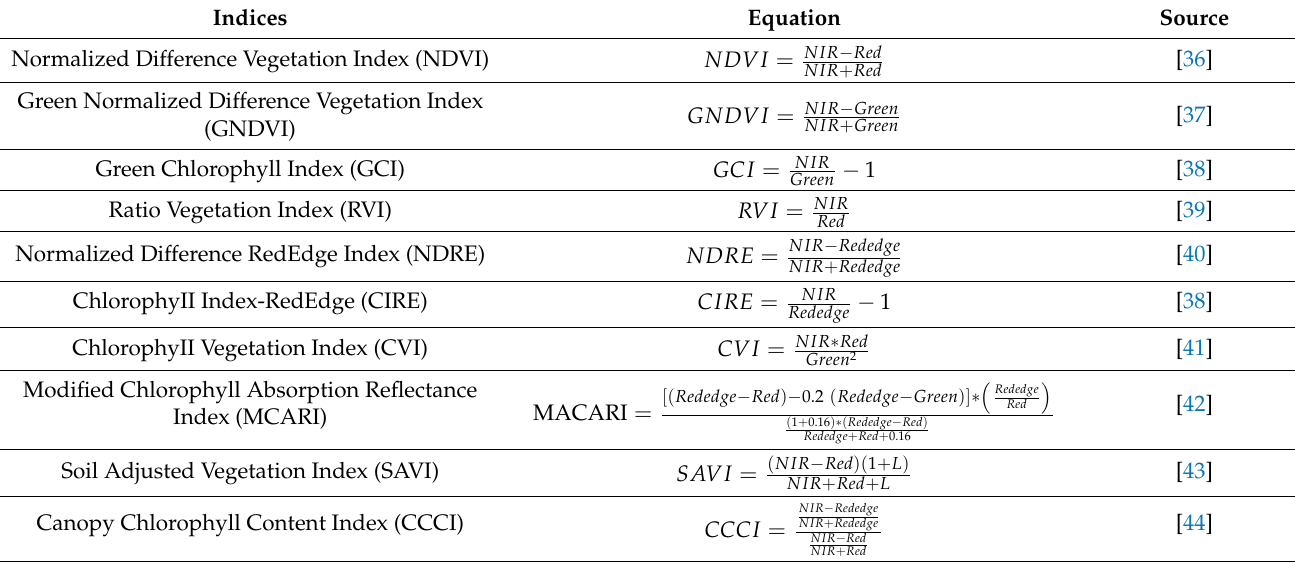
Table 1. Vegetation indices applied for maize yield evaluation.